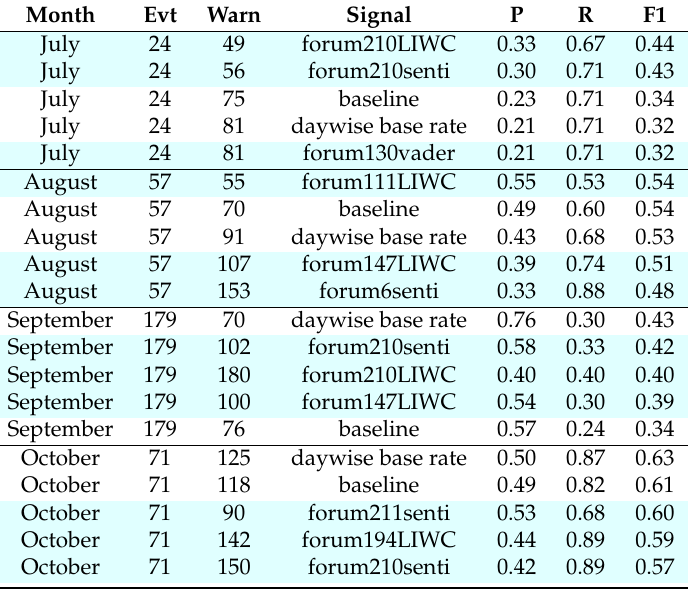
Table A6. Results from Organization B’s malicious